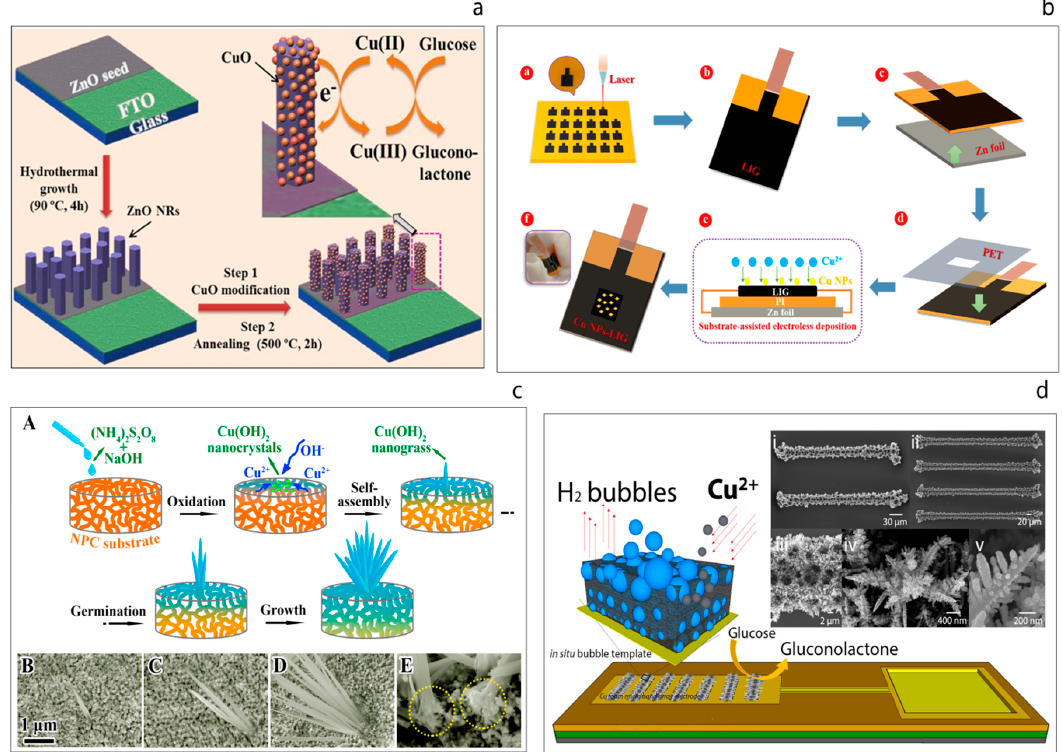
Figure 7. ( a ) Schematic illustration of non-enzymatic glucose sensor electrode fabrication and its application in glucose detection [99]. ( b ) Schematic illustration of fabrication process of the flexible Cu NPs-LIG sensor [100]. ( c ) Schematic illustration of the growth process of the Cu(OH) 2 nanograss structure on a NPC substrate (A), the corresponding surface SEM images at different growth stages (B–D), magnified cross-section of the fabricated nanohybrid (E) [101]. ( d ) Hydrogen bubble template-based electrodeposition process of the copper foam and the SEM images of the resulting CuFoam electrodeposits